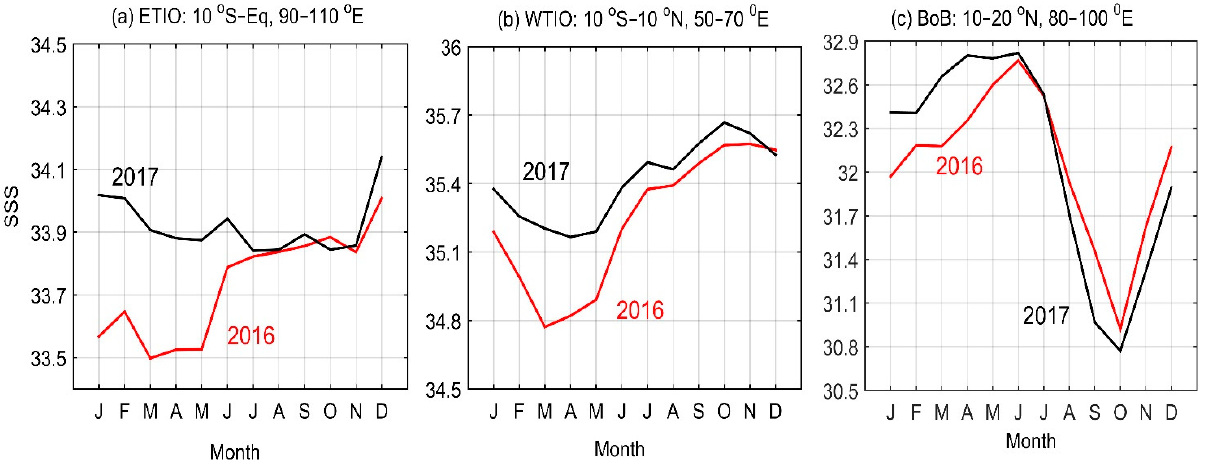
Figure 14. SSS variability in the TIO in the areas under investigation during 2016 and 2017: ( a ) ETIO (10 ◦ S–Eq, 90–110 ◦ E), ( b ) WTIO (10 ◦ S–10 ◦ N, 50–70 ◦ E), and ( c ) BoB (10–20 ◦ N, 80–100 ◦ E). Data obtained from the SMAPv3 (Soil Moisture Active Passive version 3).